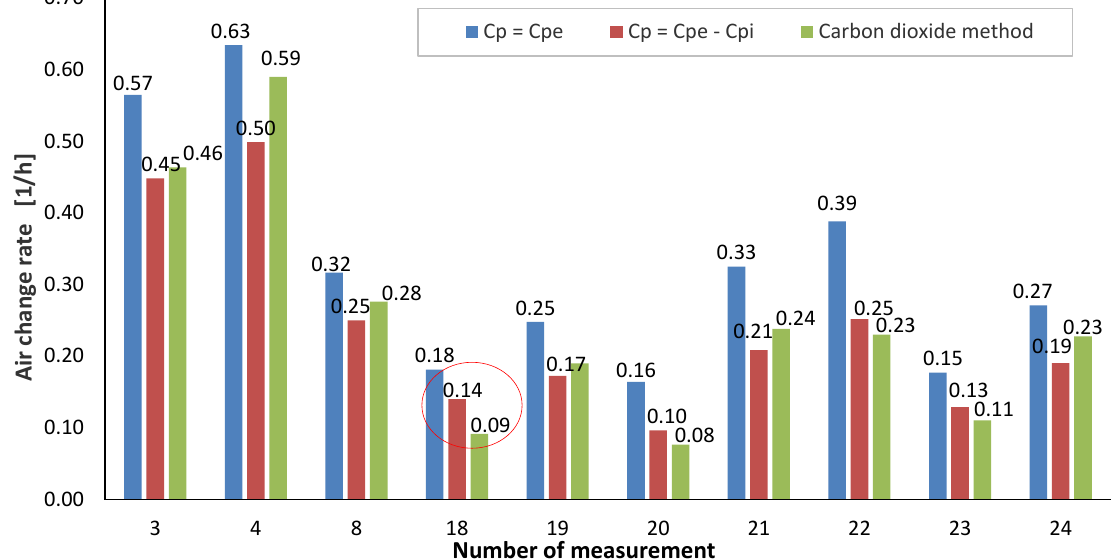
Figure 11. Comparison of the values of air change rate without considering the influence of openings C p = C pe , with considering the effect of openings C p = C pe − C pi and calculation based on experimental measurements of carbon dioxide for higher wind speed v = 4.4 m/s–10.3 m/s.